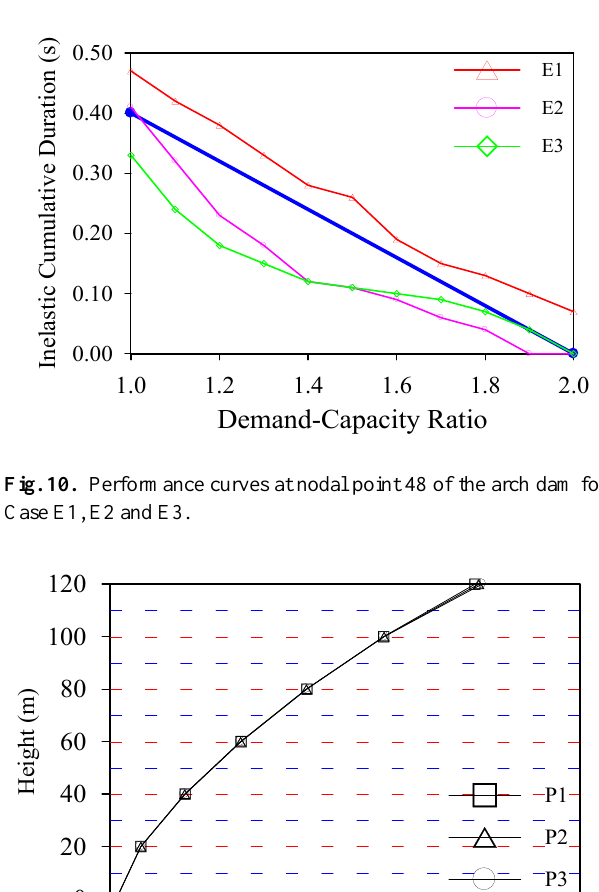
P1 P2 P3 Fig. 11. The variation of maximum displacements on II-II section of the arch dam for Case P.